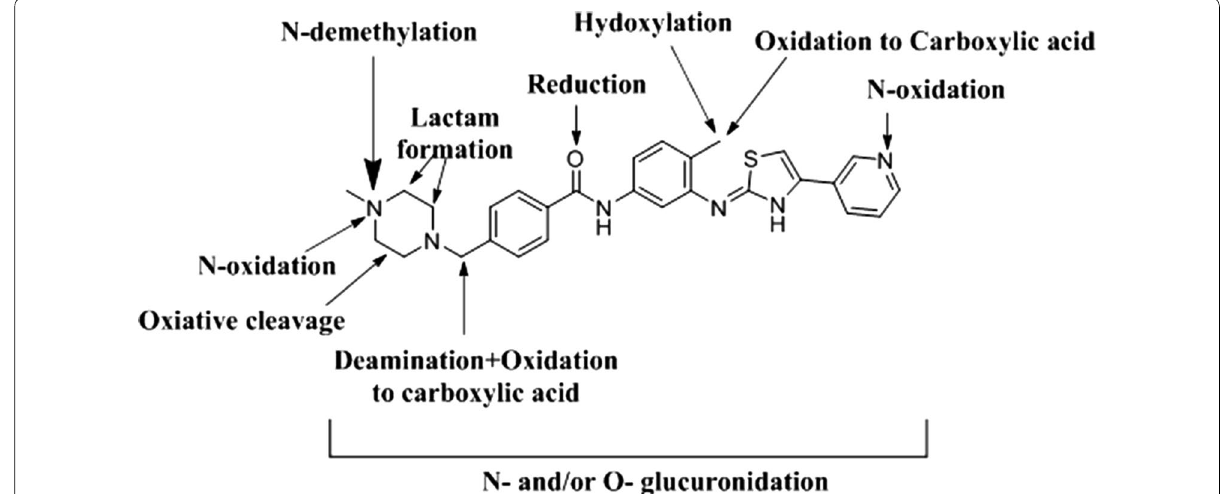
Fig. 20 Chemical structure of MST and identified metabolic pathways in Rat. The main metabolic pathway was the